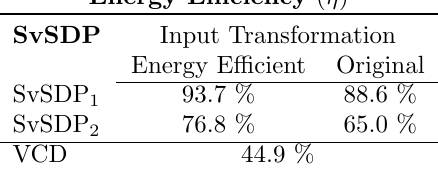
Table 1: Evaluated energy efficiencies for the test trajectory.